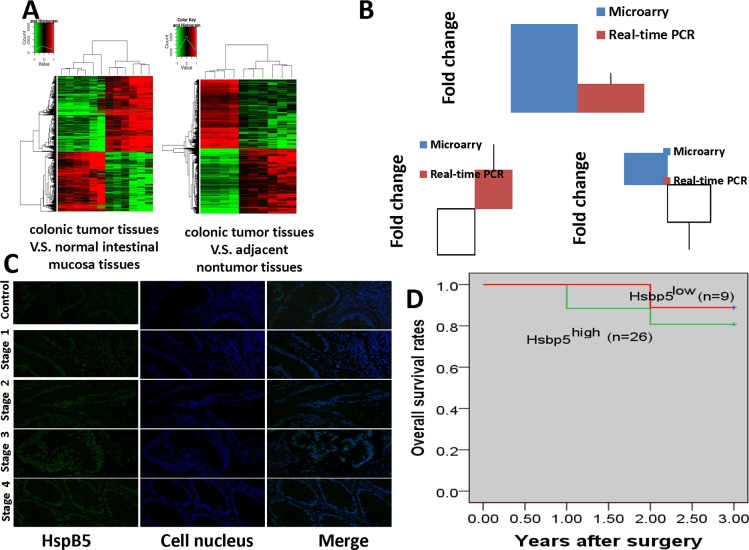
HspB5 over-expression correlated with CRC patients.A:Hierarchical clustering of gene expression in CRC patients (N = 6). Red and green indicated high and low relative level, respectively. B: A comparison between qRT-PCR (N = 70) and gene microarray assay (N = 6) in CRC patients. The groups were divided into two groups, colonic tumor tissue and their adjacent nontumor tissue. qRT-PCR showed the up-regulation of HspB5 and MMP7, and down-regulation of E-cadherin in CRC patients. C: Immunofluorescence staining of HspB5 expression in CRC patients. Green fluorescence and blue fluorescence respectively represents HspB5 and the cellular nucleus. Stage 1, T1(mucosa); Stage 2, T2(muscle); Stage 3, T3(serosa); Stage 4, T4(viscera). D:HspB5 indicates poor survival in colorectal cancer during a 3-year follow up (N = 35).CRC patients with high HspB5expression had a shorter overall survival rate than those with low expression levels.